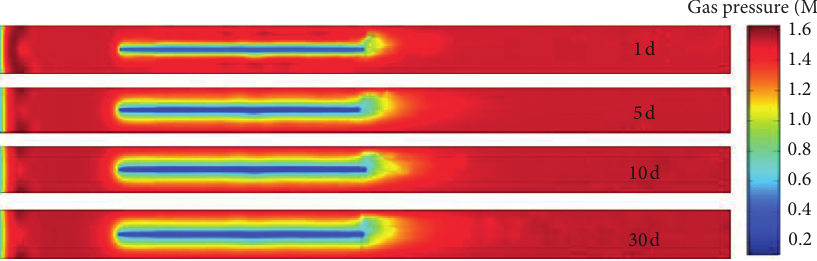
Figure 7: The gas pressure distribution of plug hole in the coal seam.